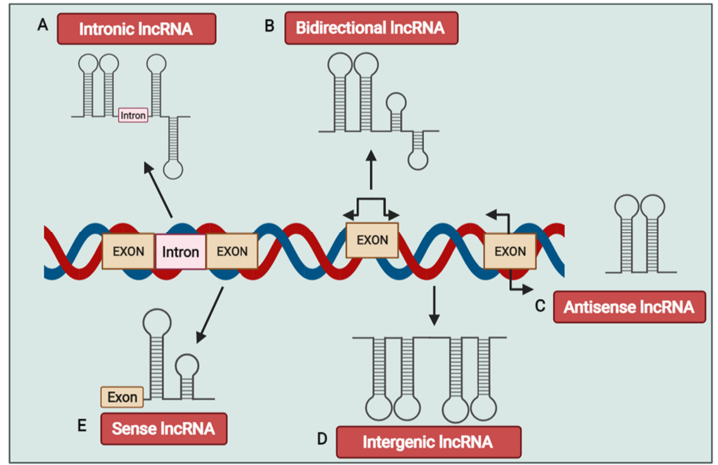
Figure 1. Overview of long non-coding RNA (lncRNA) classification. Based on the genomic position and origin, lncRNAs classified in 5 group including sense, antisense, bidirectional, intronic, and intergenic lncRNAs. Interonic lncRNAs are transcribed in the genomic region between two coding areas (Exons) ( A ). Bidirectional lncRNAs are transcribed from the opposite strand, in the opposite direction ( B ). Antisense lncRNAs are transcribed from the opposite strand of coding ex- ons ( C ). Intergenic lncRNAs are transcribed from the intergenic regions of protein coding genes ( D ). Sense lncRNAs are transcribed from the sense strand of an intronic region with no overlap of exonic sequence ( E ).